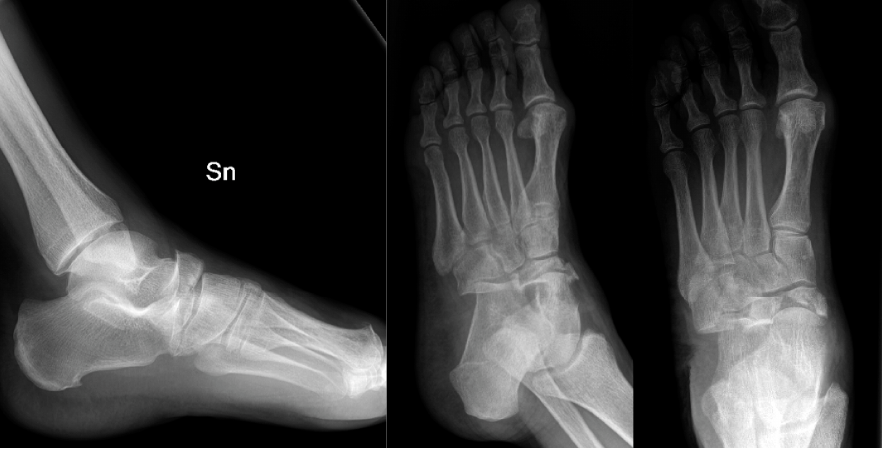
Figure 1. Preoperative